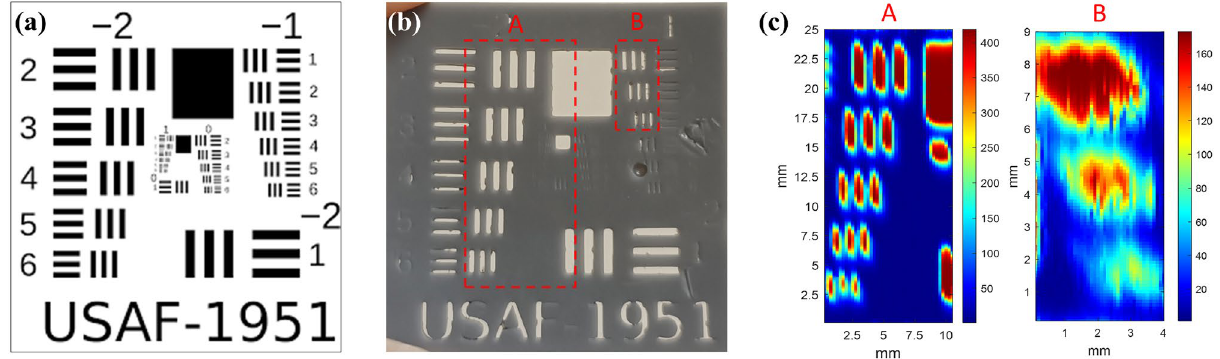
Figure 9. ( a ) The USAF-1951 test chart. ( b ) The optical image of the 3D-printed 3.4 cm × 3.4 cm USAF-1951 chart. ( c ) The 5.7-THz images of the boxed areas in ( b ). The least discernible bars have widths between 488 and 464 μm for Patterns − 2:6 and − 1:1,